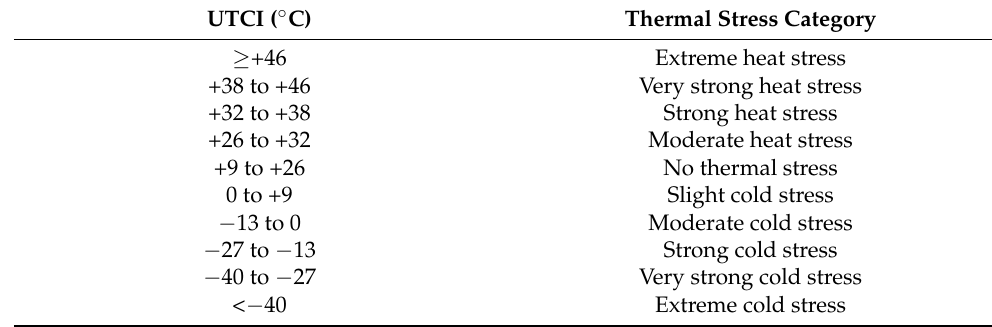
Table 4. Thermal stress classification for the Universal Thermal Climate Index (UTCI).